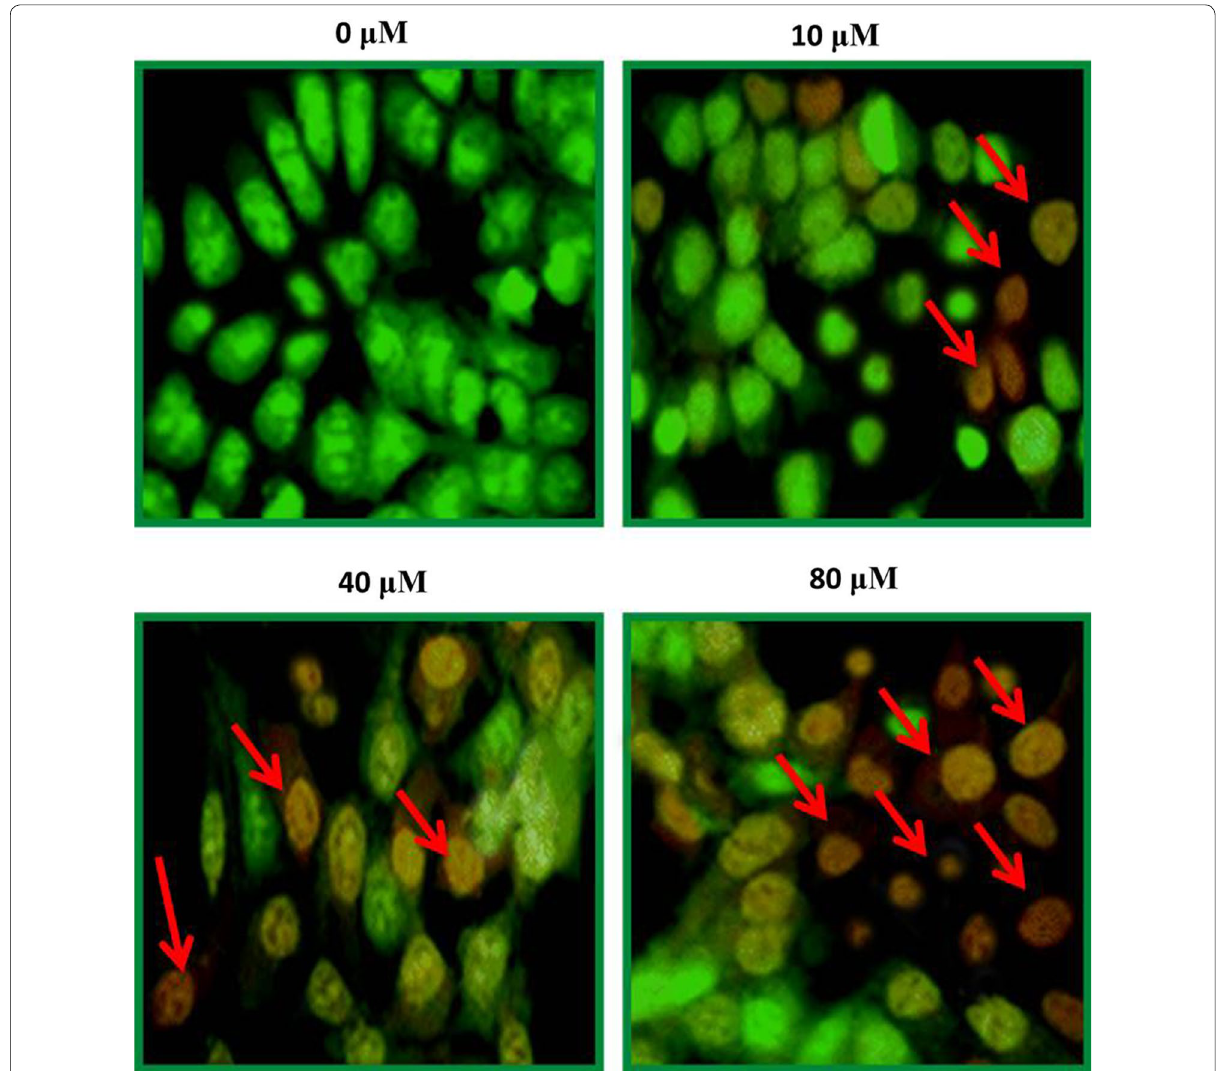
Fig. 4 A concentration of 4 10 5 cells was loaded to 24-well plates and maslinic acid treatment was performed for 24 h at indicated doses. Results × revealed early and late apoptotic, and necrotic cellular morphology through fluorescence microscopy and represented by arrows. For maximum precision three individual experiments were